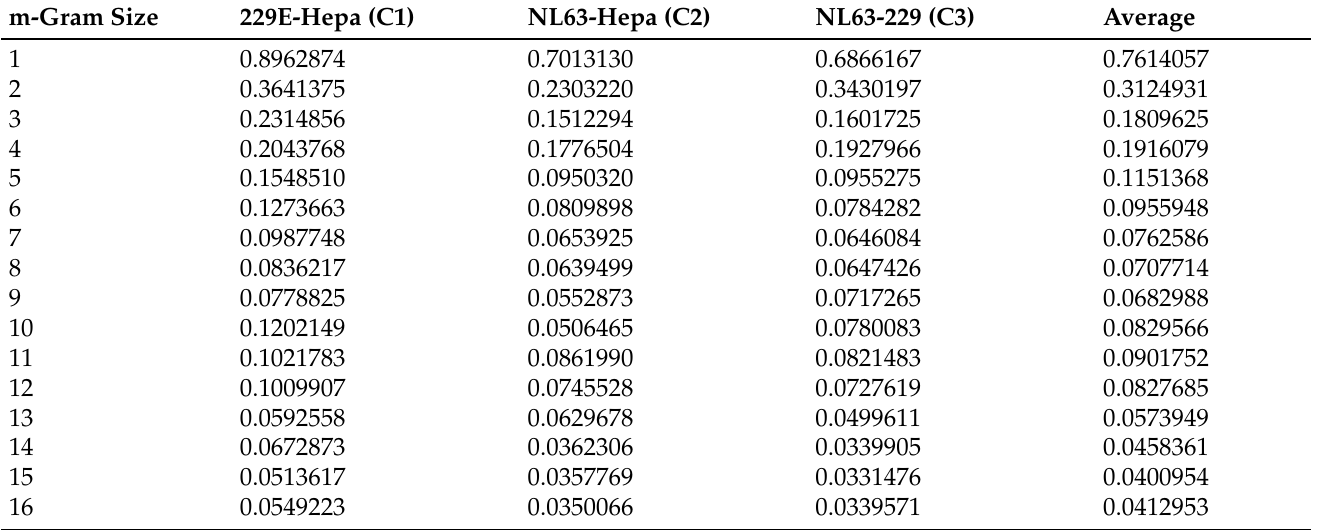
Table 5. Running times at the calculation of the similarity scores (229E-Hepa ( C1 ), NL63-Hepa ( C2 ), and NL63-229 ( C3 )) of the MinHash of the three viruses and the average of these running times in seconds using different m-gram